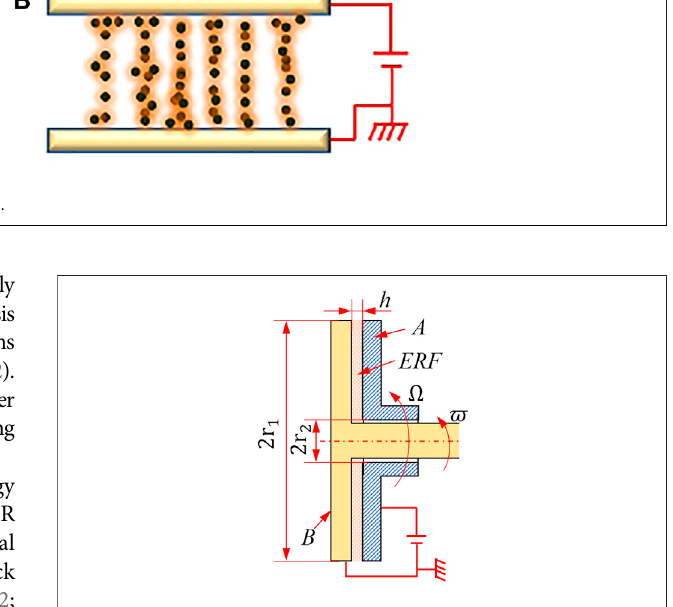
FIGURE 2 | Diagram of disc type ER transmission